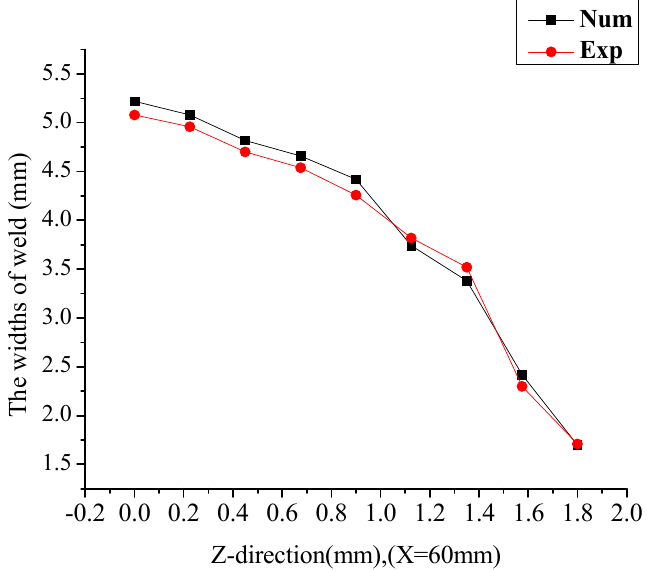
Figure 8. Comparison of predicted weld bead widths and those experimentally obtained at different depths of fusion.